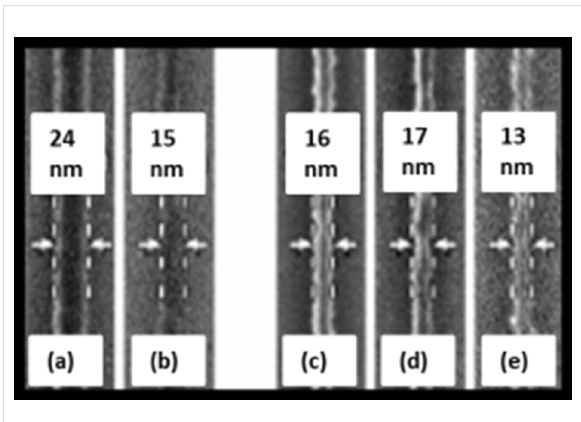
Figure 12: Carbonaceous nanowires on bulk SiO 2 such as the one in (a) slimmed by electron beam induced etching in the presence of water in an ESEM resulting in wires of different widths (b–e). Adapted with permission from [94], copyright 2007 American Chemical